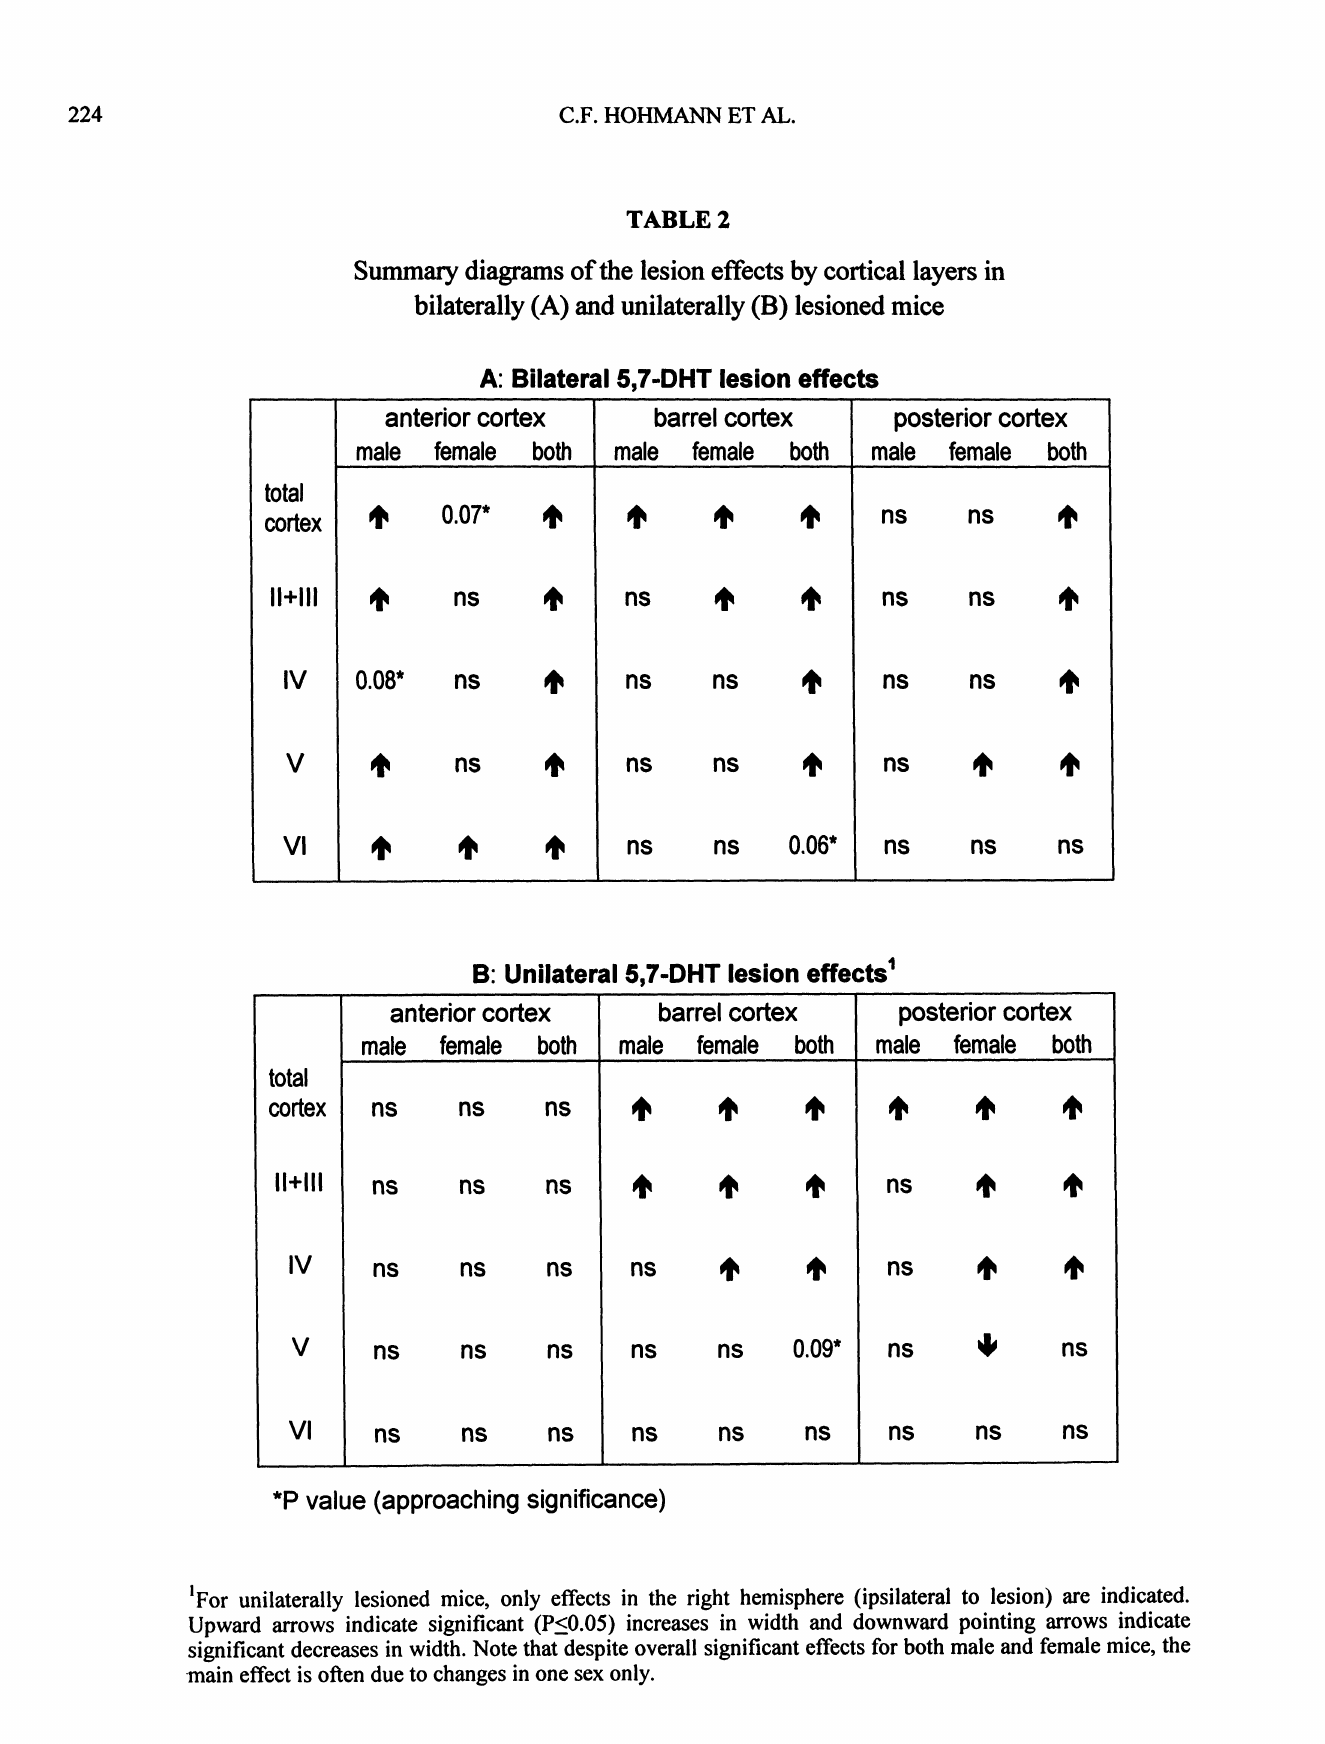
Summary diagrams of the lesion effects by cortical layers in bilaterally (A) and unilaterally (B) lesioned mice A: Bilateral 5,7-DHT lesion